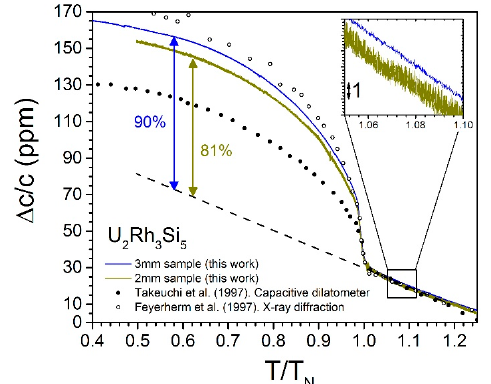
Figure 12. c-axis dilation Δ c/c vs. reduced temperature T/T N , where T N = 25.5 K, for two samples of U 2 Rh 3 Si 5 of identical cross section and different lengths, 2 mm (green) and 3 mm (blue), respectively, measured with a 0.5 mm long FBG. The magnitude of the effect of entering the antiferromagnetic phase for T < T N is smaller for the smaller sample, with larger scattering (see inset). Data taken with a capacitive dilatometer ( • , Takeuchi et al. [54]) and inferred from x-ray diffraction ( X-ray data is satisfactorily explained by the strain transfer coefficient given by Equation (3) when using the parameters listed in Table 1. Inset. Effect of the sample length on the measurement sensitivity.